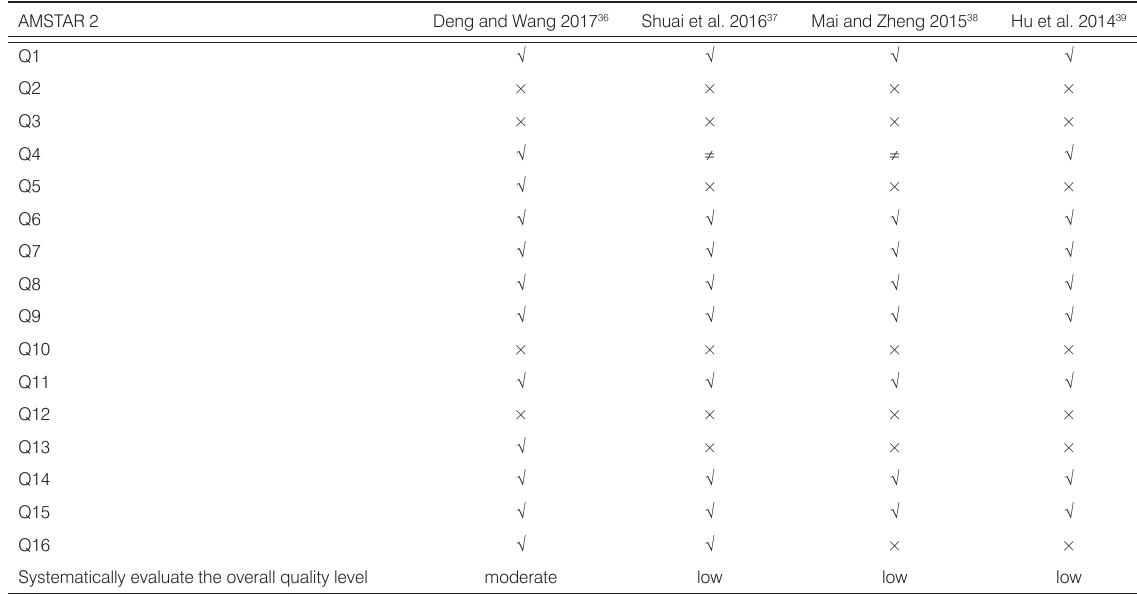
Table 7. Assessment of the methodological quality of systematic reviews (SRs) evaluating acupuncture.